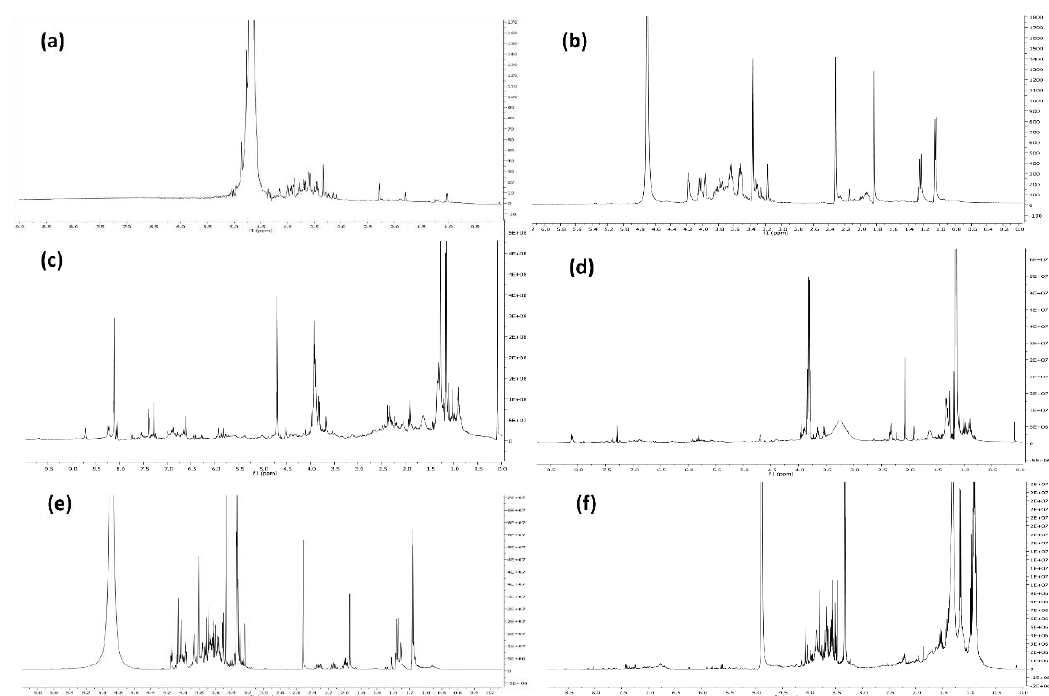
Figure 1. ( a ) 1 H NMR spectrum of the aqueous stock extract recorded at 400 MHz in D 2 O; ( b ) 1 H NMR spectrum of the dialysis tubes content after dyalization of the aqueous stock extract recorded at 400 MHz in D 2 O; ( c ) 1 H NMR spectrum of the CH 2 Cl 2 organic extract recorded at 400 MHz in CDCl 3 ; ( d ) 1 H NMR spectrum of the EtOAc organic extract recorded at 400 MHz in CDCl 3 ; ( e ) 1 H NMR spectrum of the n -butanol organic extract recorded at 400 MHz in CD 3 OD; ( f ) 1 H NMR spectrum of the EtOAc organic extract obtained acidifying the stock solution at pH 2 recorded at 400 MHz in CD 3